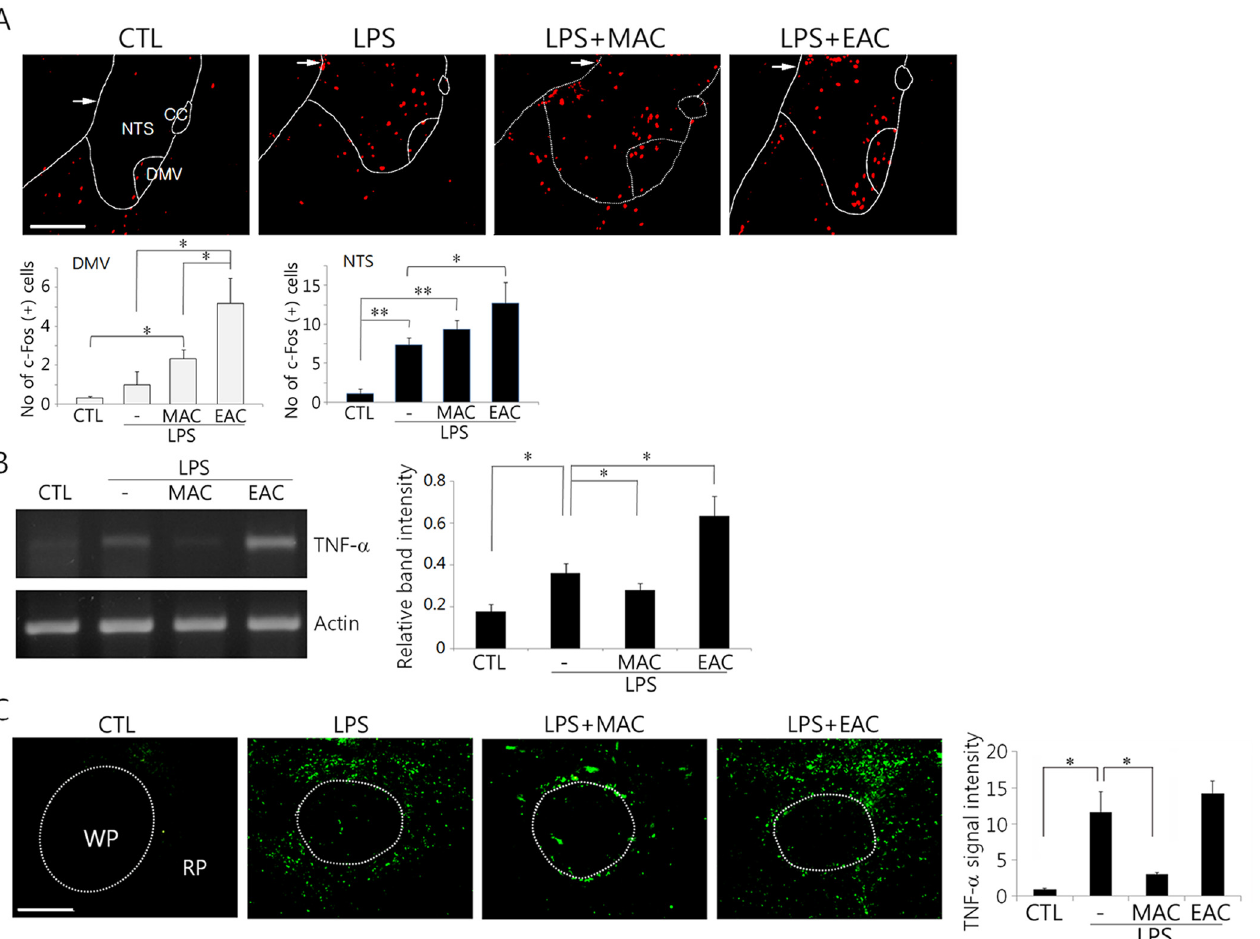
Fig 6. In vivo inductions of c-Fos and TNF- α in animals given LPS and AS without anesthesia. Sixty minutes after LPS injection, MAC or EAC was given at ST36 for 30 min. Animals were sacrificed 90 min after AS for analyses of the changes in both c-Fos protein signals in the transverse sections through the caudal portion of the brainstem (A) and the TNF- α mRNA and protein in the spleen (B and C, respectively). Quantitations of both the band intensity of splenic TNF- α mRNA relative to the actin control in (B) and the c-Fos and the TNF- α signals in (A) and (C) are shown in bar graphs (mean ± SEM, n = 4 independent experiments). * p < 0.05 and ** p < 0.01 (one-way ANOVA). Arrows in (A) and (B) denote the approximate NTS boundary between two hemispheres. cc: central canal, WP: white pulp, RP: red pulp. CTL: non-treated control. The scale bars in (A) and (C) are 100 μ